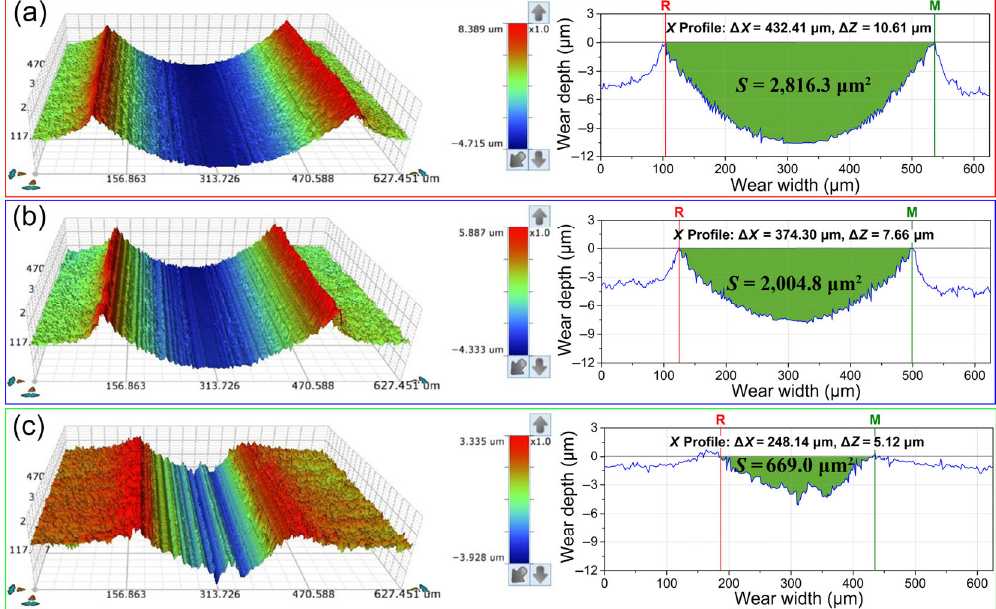
Fig. 9 3D and 2D profiles of wear tracks of the disks lubricated with (a) PEG200, and (b) A-g-CNPs/PEG200 and (c) C-g-CNPs/PEG200 dispersions (0.7 wt%) under the conditions of 100 N and 20